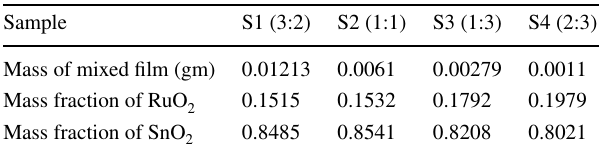
2 -RuO 2 mixed films for differ-